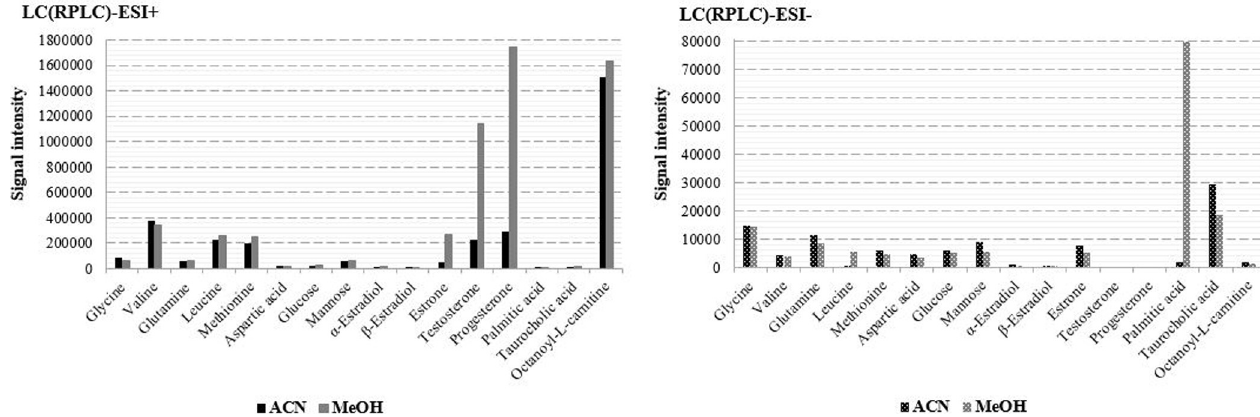
ACN had a positive impact on the ionization intensity of most IS compounds (Fig 1). Indeed, ionization was increased for 10 targeted compounds over 16 analyzed on the C18 column, and slightly decreased for the amino acids valine, glycine and aspartic acid. The increase was espe- cially noticeable in the case of hormones, with intensities enhanced by a factor 5 to 8 with MeOH. On the contrary, with ESI- most compounds presented higher intensities with ACN, except palmitic acid that exhibited a very low intensity and leucine which was no longer detect- able with ACN. When considering the compounds detected in both positive and negative modes, 12 of the 14 corresponding compounds showed higher intensities in the positive mode, from 4 to 1000 times higher using MeOH and from 2 to 800 times higher with ACN as organic modifier.